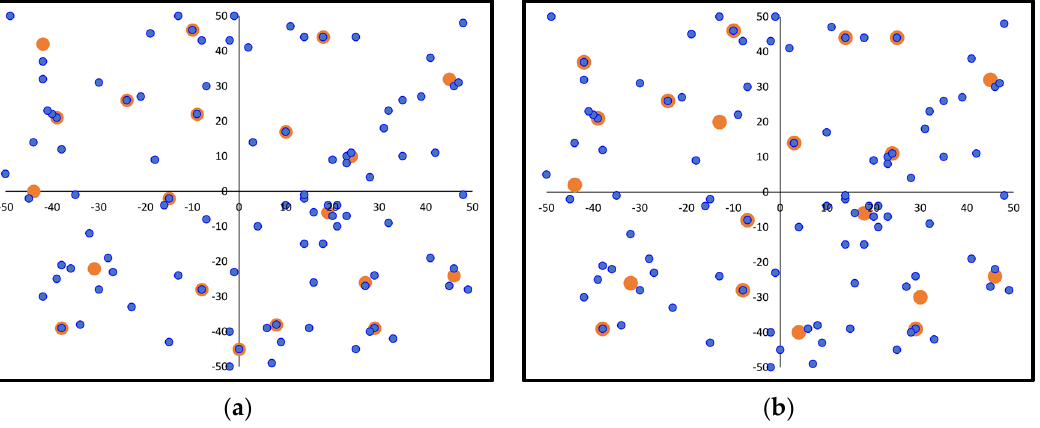
Figure 14. Indicative deployment optimization results of a 20-station network: ( a ) single-phase allocation; ( b ) two-phase allocation (demand points in blue color, charging stations in orange color).